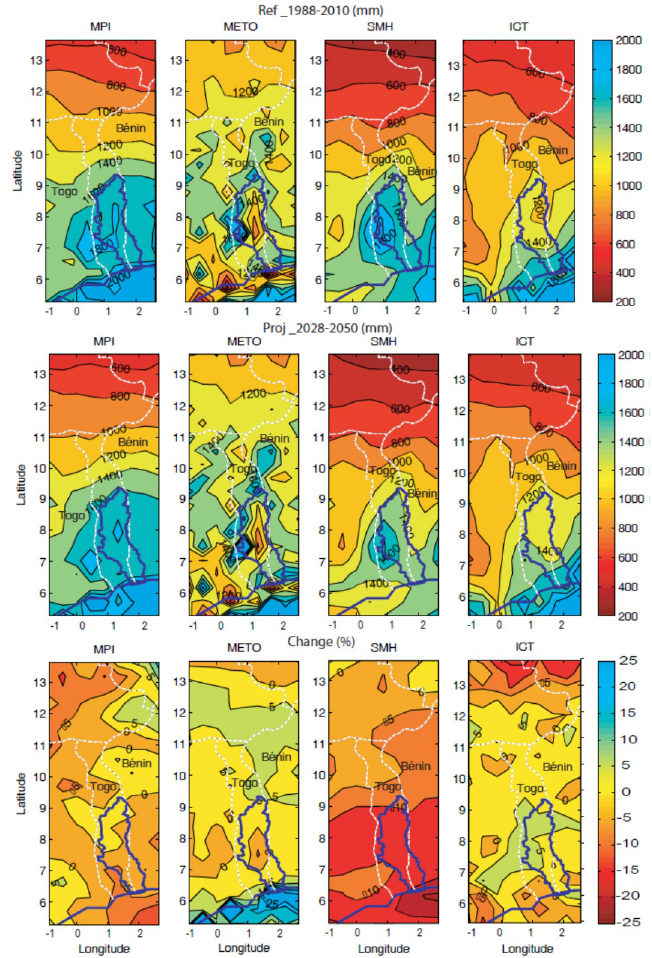
Figure 4. Spatial variation of the mean annual precipitation in the Mono river basin and surrounding areas as modeled by the four Regional Climate Models (RCMs). Upper panels: 1988–2010 reference period; Middle panels: 2028–2050 projection period; Bottom panels: variation between the reference and the scenario periods (%).